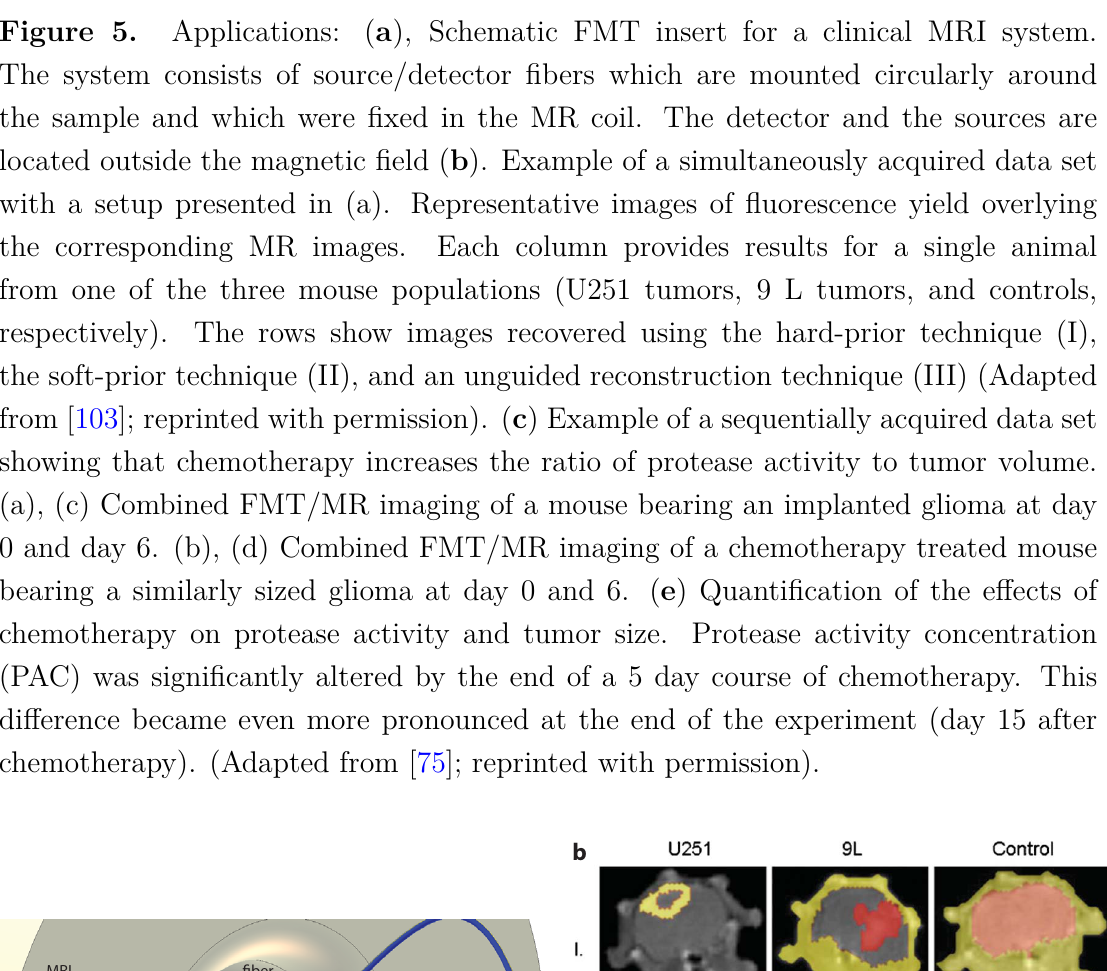
Figure 5. Applications: ( a ), Schematic FMT insert for a clinical MRI